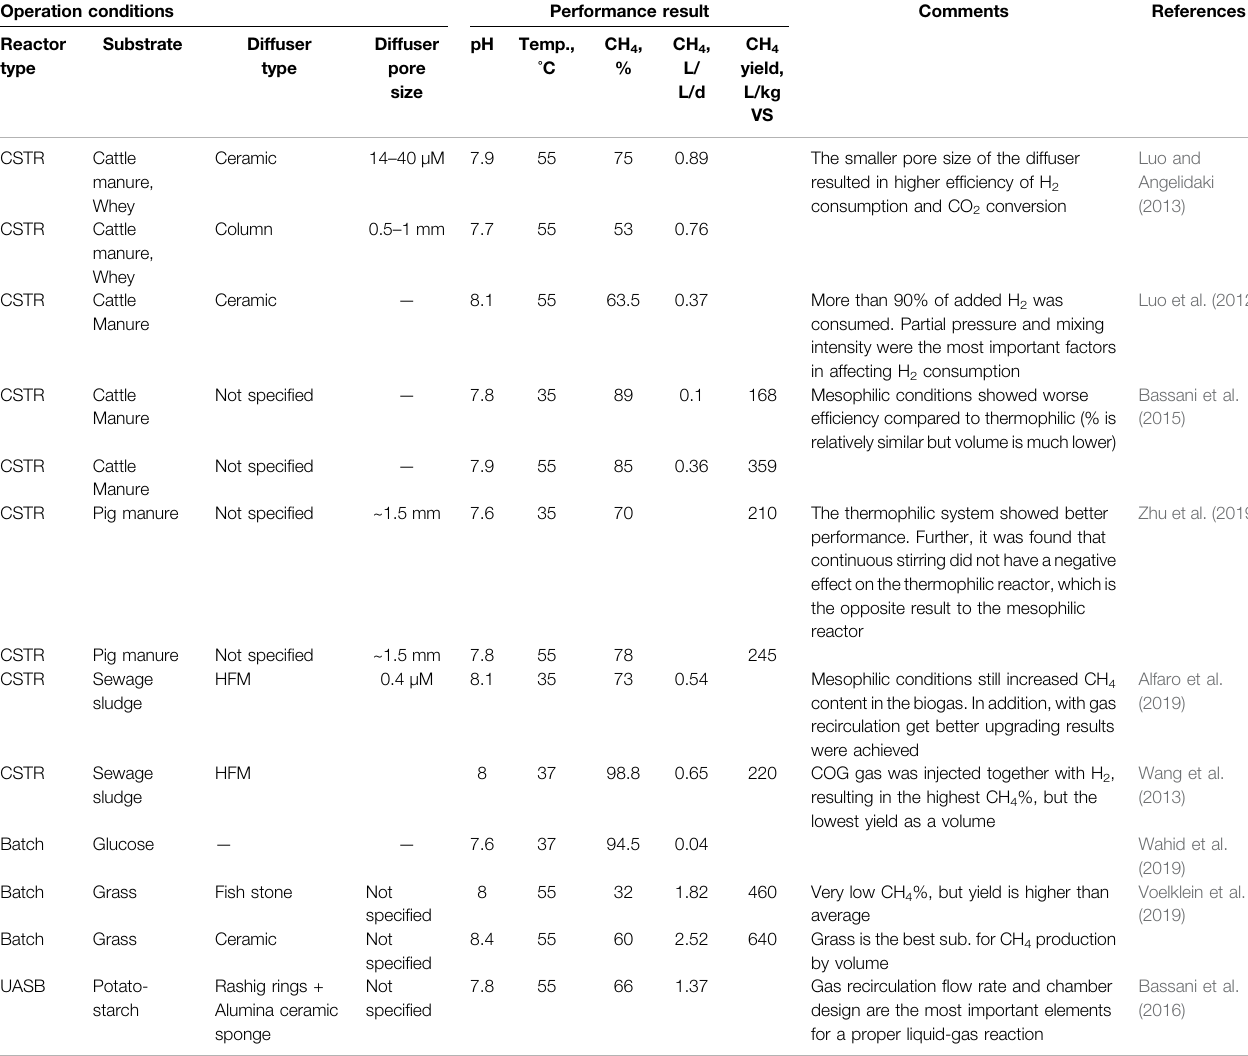
TABLE 1 | Comparison on the ef fi ciency of in-situ methanation systems. Operation